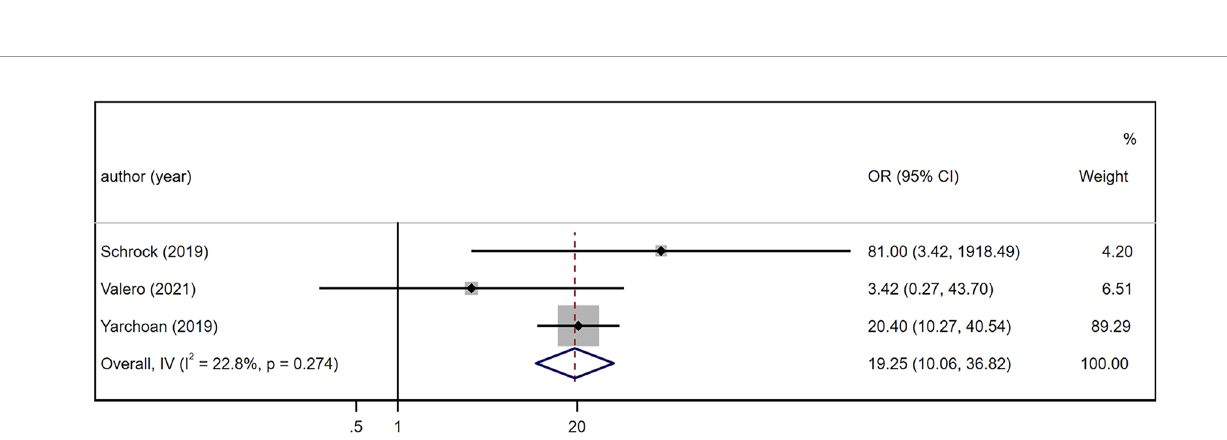
FIGURE 2 | Forest plot of meta-analysis results of the association between overall survival and TMB. TMB, tumor mutation burden; HR, hazard ratio; CI, con fi dence interval.